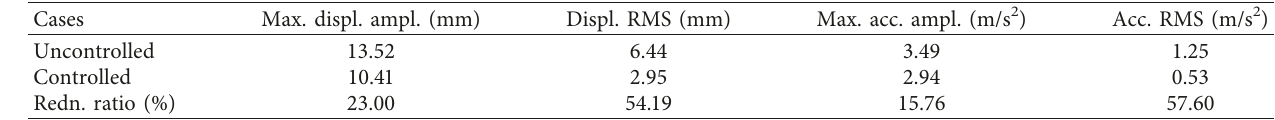
Figure 26: Time history of dynamic response under Cape Mendocino excitation. (a) Displacement. (b) Acceleration. Table 6: Dynamic responses of the main structure under Cape Mendocino excitation.